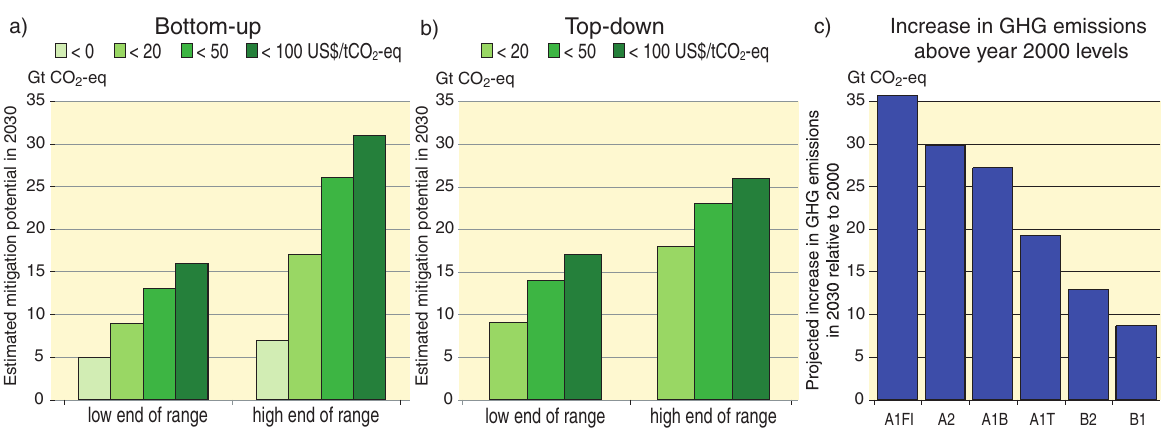
Figure SPM.9. Global economic mitigation potential in 2030 estimated from bottom-up (Panel a) and top-down (Panel b) studies, compared with the projected emissions increases from SRES scenarios relative to year 2000 GHG emissions of 40.8 GtCO in 2000 are exclusive of emissions of decay of above ground biomass that remains after logging and deforestation and from peat fires and drained peat soils, to ensure consistency with the SRES emission results. {Figure